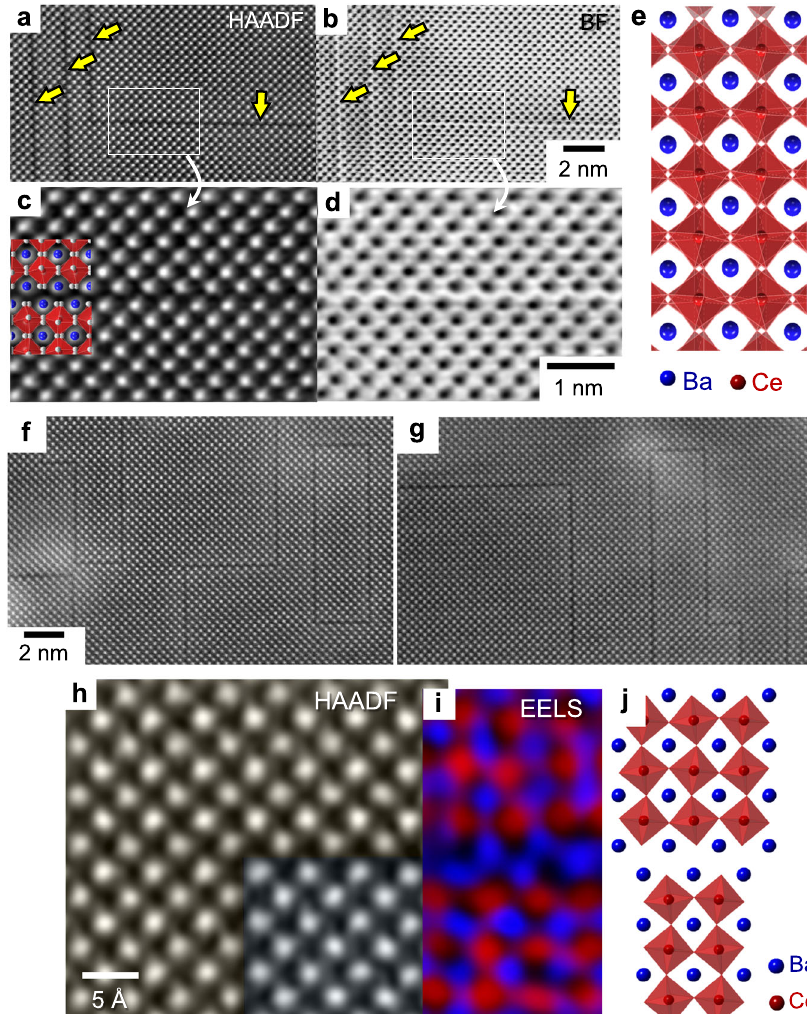
Fig. 1 | Structure and composition at RP faults in BaCeO 3 . a – d A pair of HAADF and BF STEM images a , b is provided along with the enlargements c , d , indicating the image contrast for the presence of faults, as denoted by yellow arrows. The